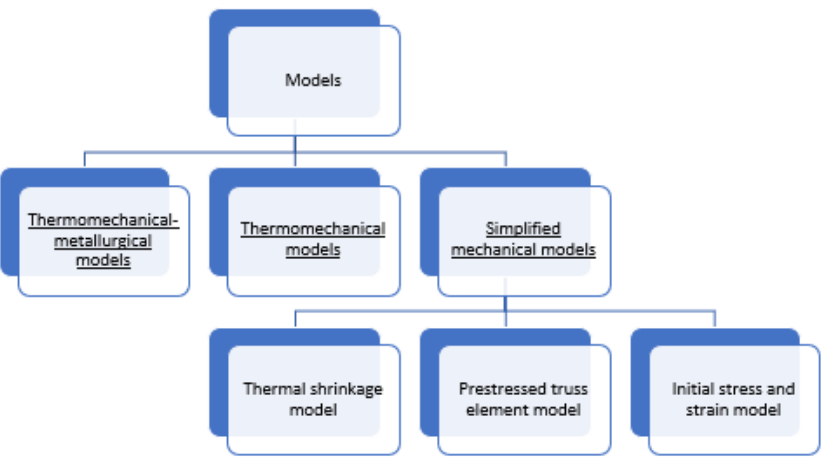
Figure 3. Types of models in finite element method (FEM) analysis, data from [6].